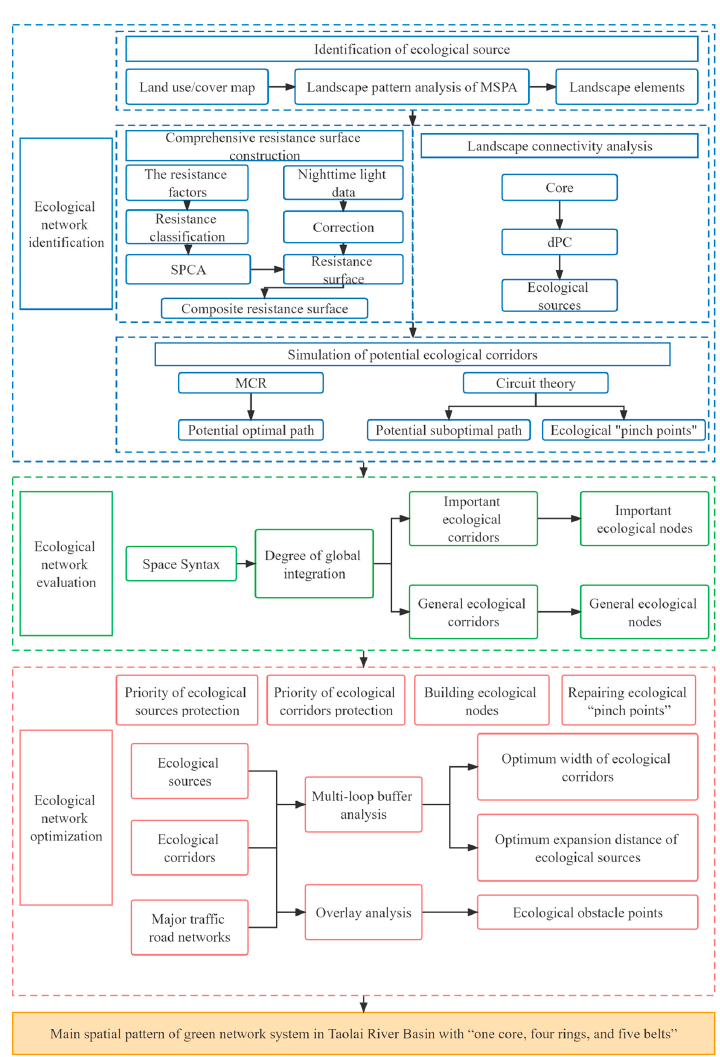
Figure 4. Study routes and block